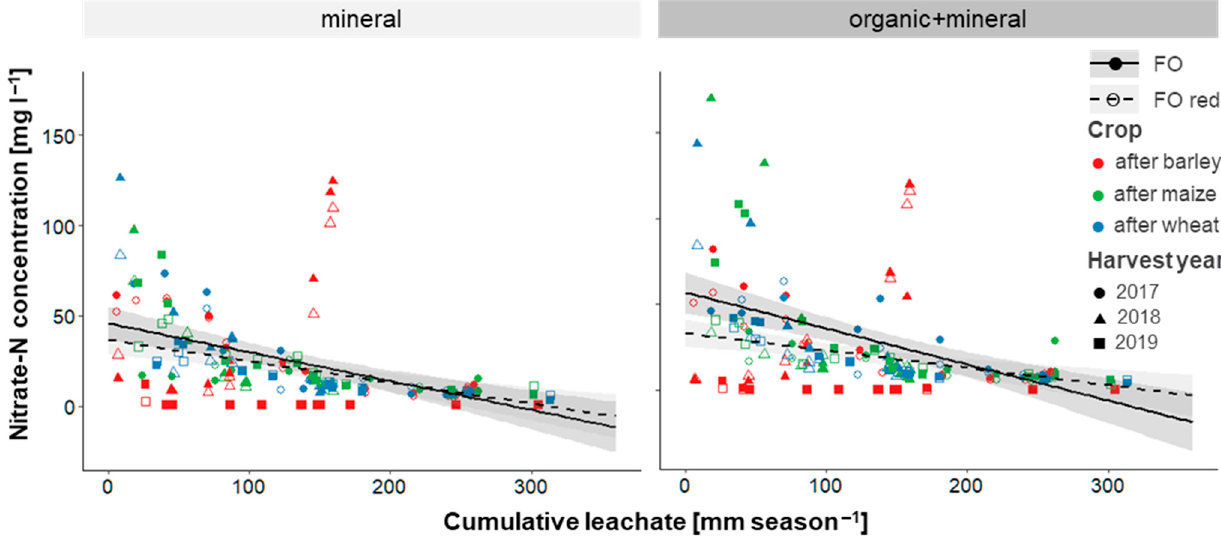
Figure 3. Nitrate-N concentrations over time during the leachate periods for fertilisation after Fertiliser Ordinance (FO) and reduced by 10/20% (FO red.).